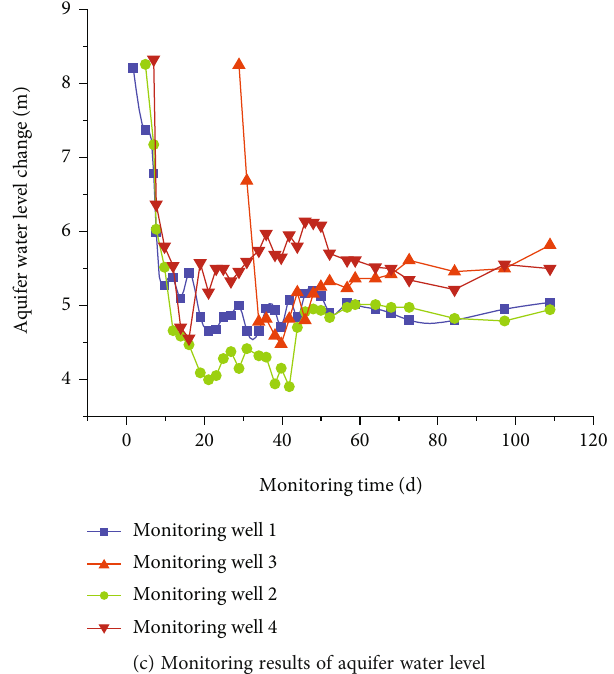
Figure 11: Comparison and veri fi cation of simulation and on-site monitoring